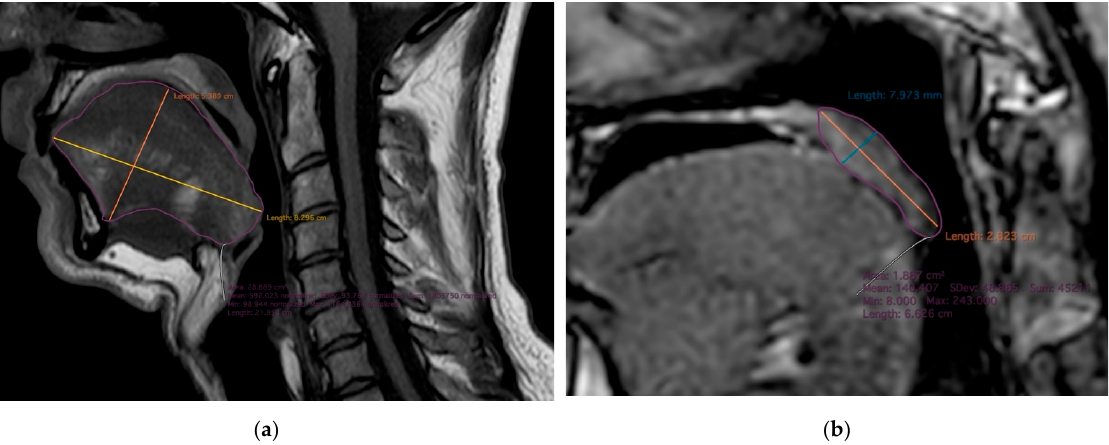
Figure 2. T1 weighted measurements of the posterior airway space on midsagittal plane ( a ) nasal (yellow), occlusal (orange) and mandibular (blue) thickness; ( b ) area (yellow curve).